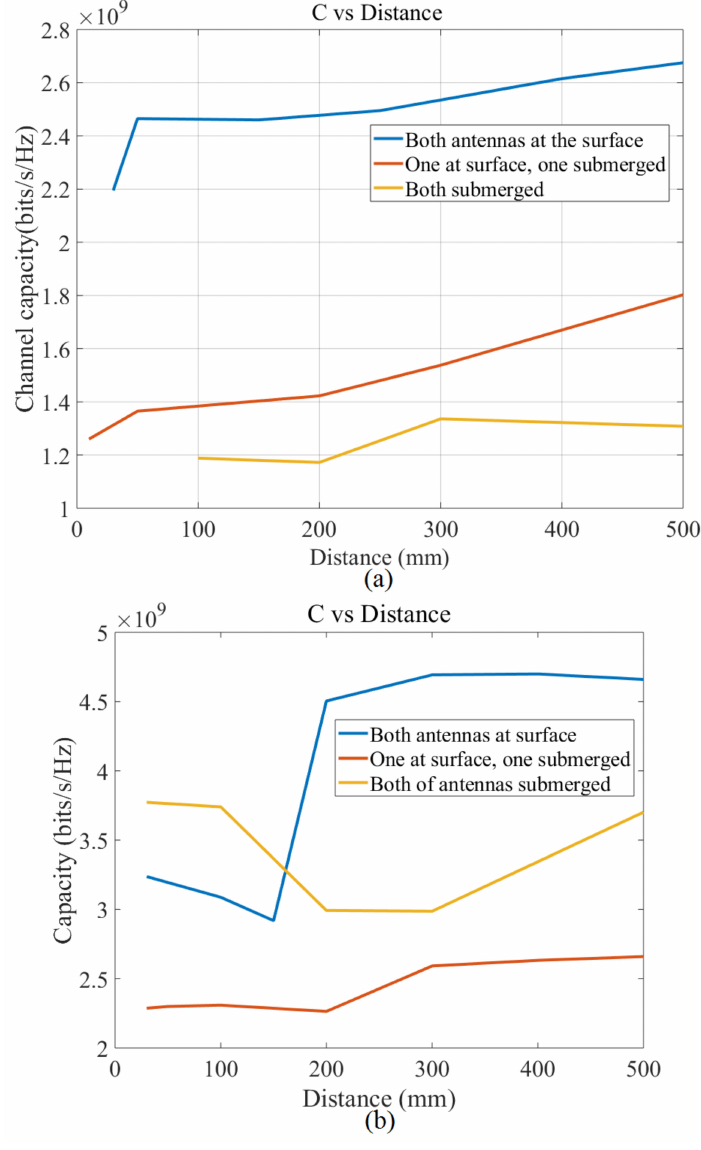
Figure 15. Channel capacity in terms of the distance between the antennas with constant bandwidth (BW) ( a ) fresh water, and ( b ) sea